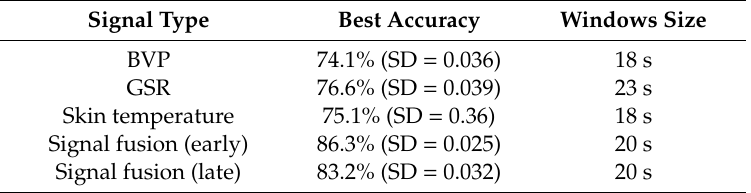
Table 3. Anxiety level prediction accuracy by signal type (using 10 × 10 fold cross validation).